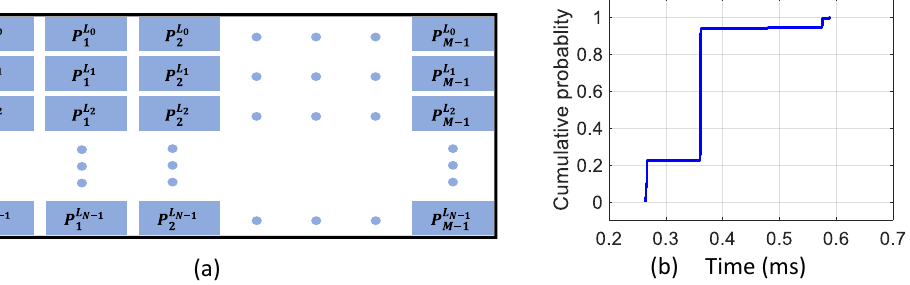
Figure 9. ( a ) organization of a 3D NAND memory block, and ( b ) cumulative distribution of the measured nominal page program time for SLC memory pages of a given block.